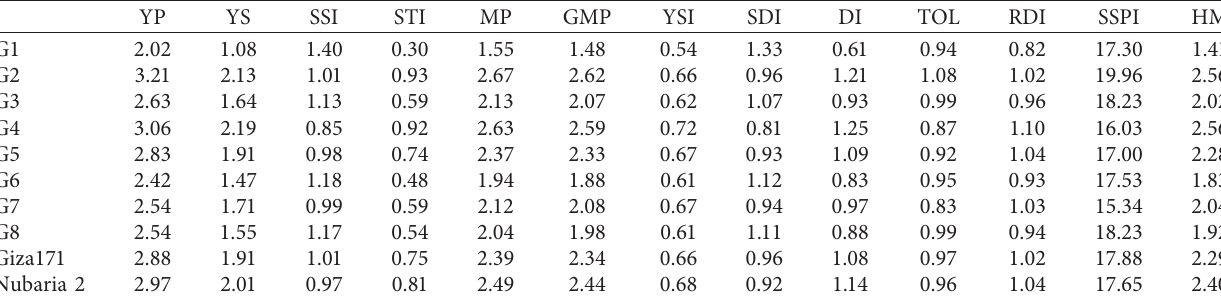
Table 6: Estimated sensitivity rate of the ten wheat genotypes by different drought tolerance indices under normal and stress conditions. YP YS SSI STI G2